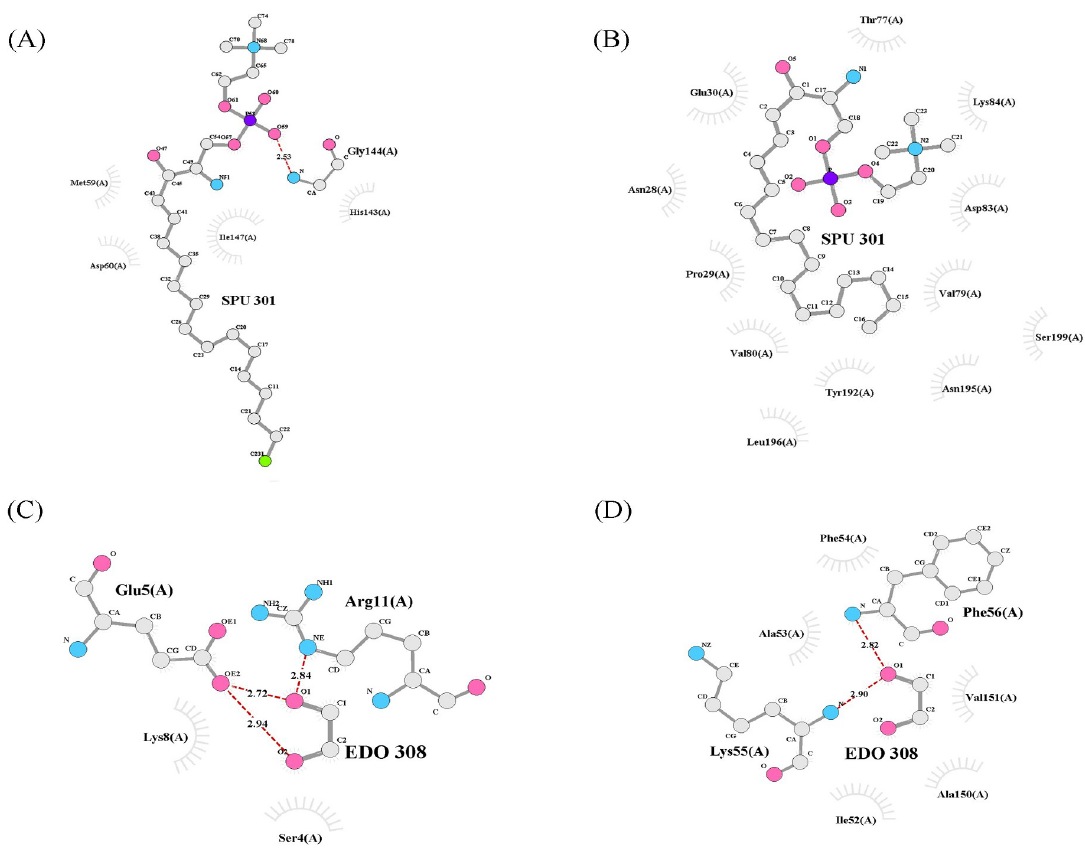
Fig 9. Ligand interaction change with protein structure of ACD11 because of A39D mutation.